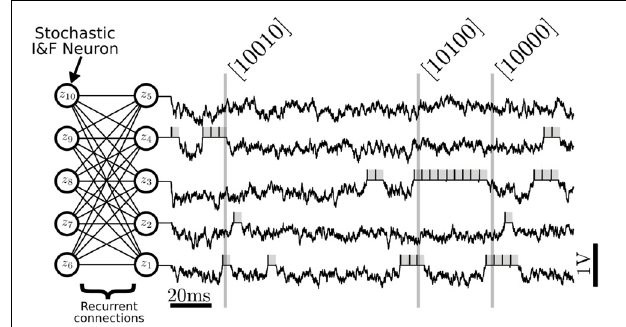
FIGURE 3 | Neural Sampling in an RBM consisting of 10 stochastic I&F neurons, with five neurons in each layer. Each neuron is associated to a binary random variable which take values 1 during a refractory period τ r after the neuron has spiked (gray shadings). The variables are sampled at 1kHz to produce binary vectors that correspond to samples of the joint distribution p ( z ) . In this figure, only the membrane potential and the samples produced by the first five neurons are shown. The vectors inside the brackets are example samples of the marginalized distribution p ( z 1 , z 2 , z 3 , z 4 , z 5 ) produced at the time indicated by the vertical lines. In the RBM, there are no recurrent connections within a layer.